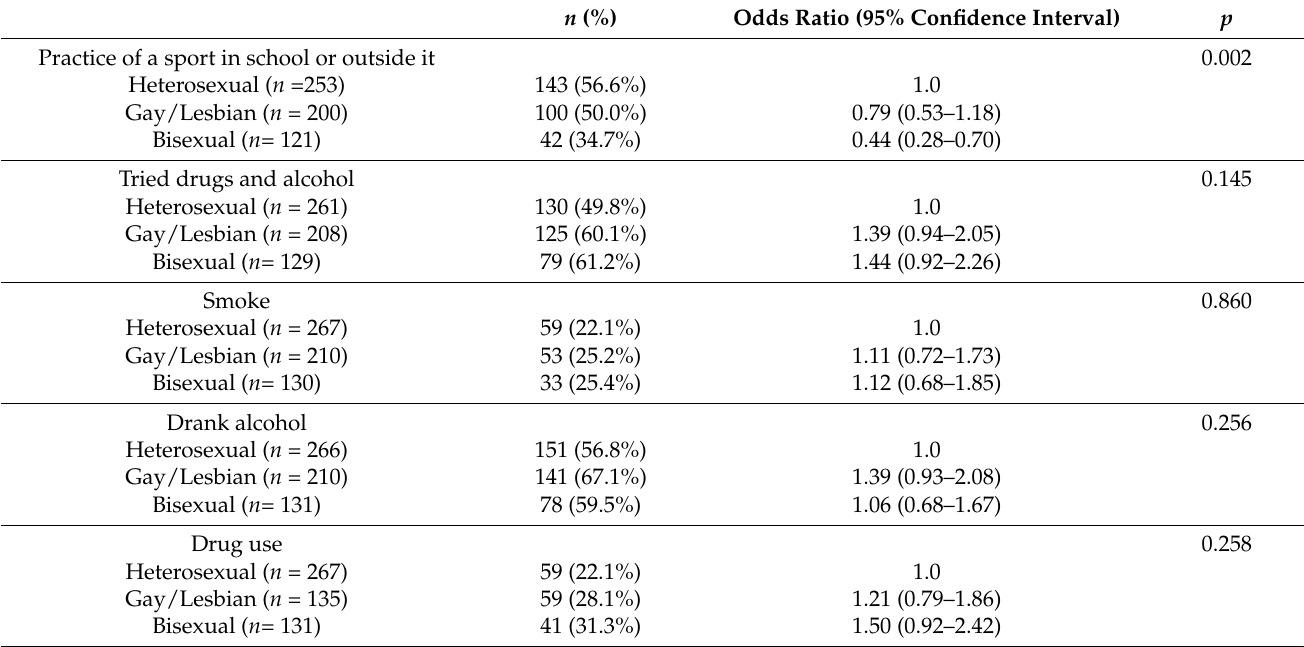
Table 3. Associations between sexual orientation and health factors.